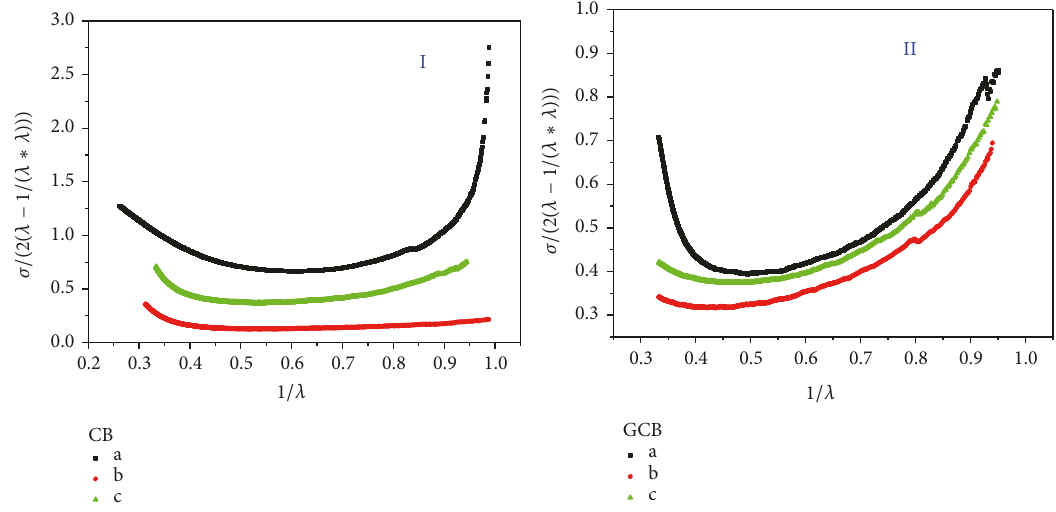
Figure 6: Mooney curves of NR/CB and NR/GCB at different